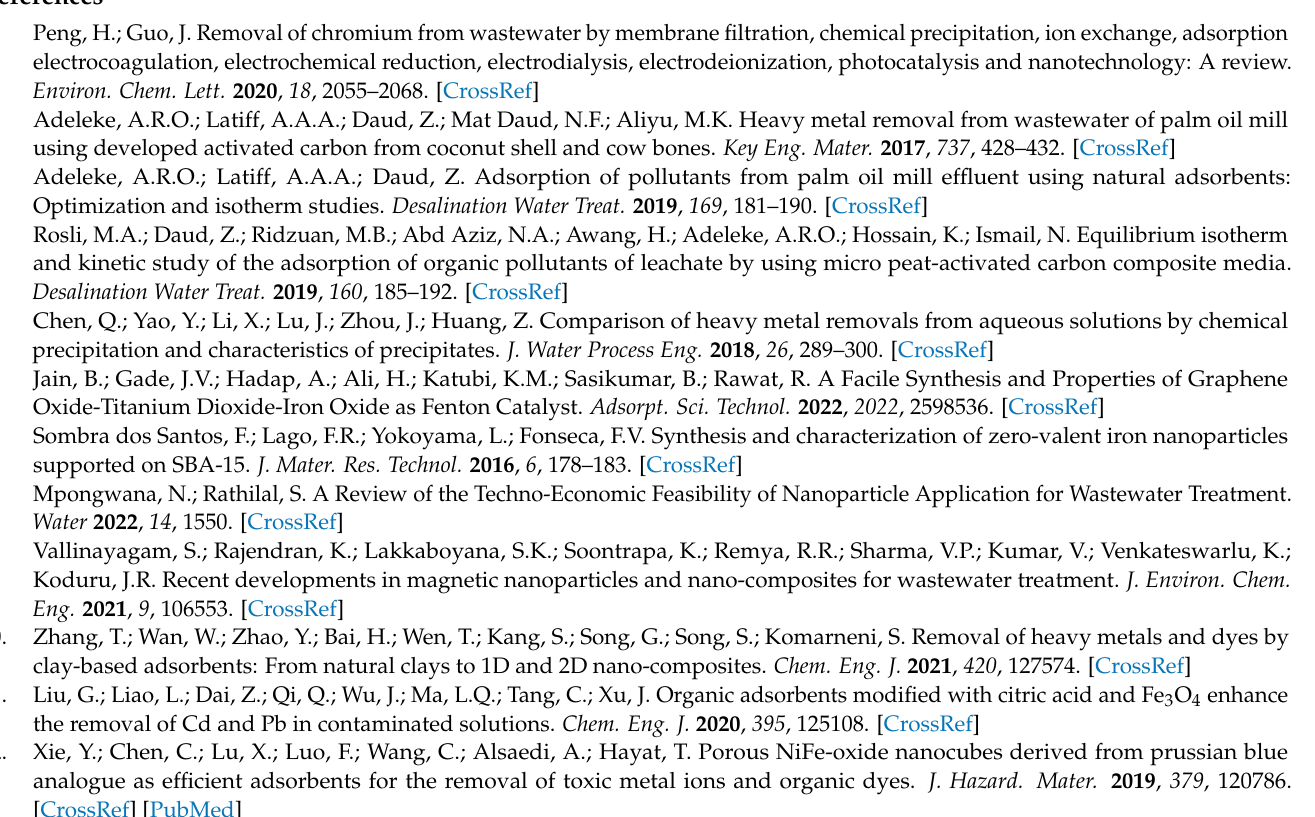
Figure S5: Effects of initial concentration and removal percentage on heavy metal (Pb (a and b), Cu (c and d), Co (e and f), Cd (g and h), Ni (i and j) and Zn (k and l)) adsorption capacity (M = 0.5 g; V = 50 mL; pH = 6; shaking time = 3 h; temperature = 25 ◦ C); Figure S6: Effect of contact time on heavy metal ((a) Pb, (b) Cu, (c) Co, (d) Cd, (e) Ni, (f) Zn) adsorption capacity (Co = 50 mg/L; M = 0.5 g; V = 50 mL; pH = 6; temperature = 25 ◦ C); Figure S7: Plot of intraparticle diffusion modeling of heavy metals ((a) Pb, (b) Cu, (c) Co, (d) Cd, (e) Ni, (f) Zn) onto adsorbents (nZVI, Gr and Gr-nZVI); Figure S8: Effect of initial pH on heavy metal ((a) Pb, (b) Cu, (c) Co, (d) Cd, (e) Ni, (f) Zn) adsorption capacity (Co = 50 mg/L; M = 0.5 g, V = 50 mL; shaking time = 3 h; temperature = 25 ◦ C); Figure S9: Effect of temperature on heavy metal ((a) Pb, (b) Cu, (c) Co, (d) Cd, (e) Ni, (f) Zn) adsorption ca- pacity (Co = 50 mg/L; M = 0.5 g; V = 50 mL; pH = 6; shaking time = 3 h); Table S1: Linear equation of adsorption isotherm and kinetic model; Table S2: BET results for all samples; Table S3: CEC for all samples; Table S4: XRF results for all adsorbent materials; Table S5: Model parameters for concentration; Table S6: Kinetic parameters for heavy metal adsorption onto